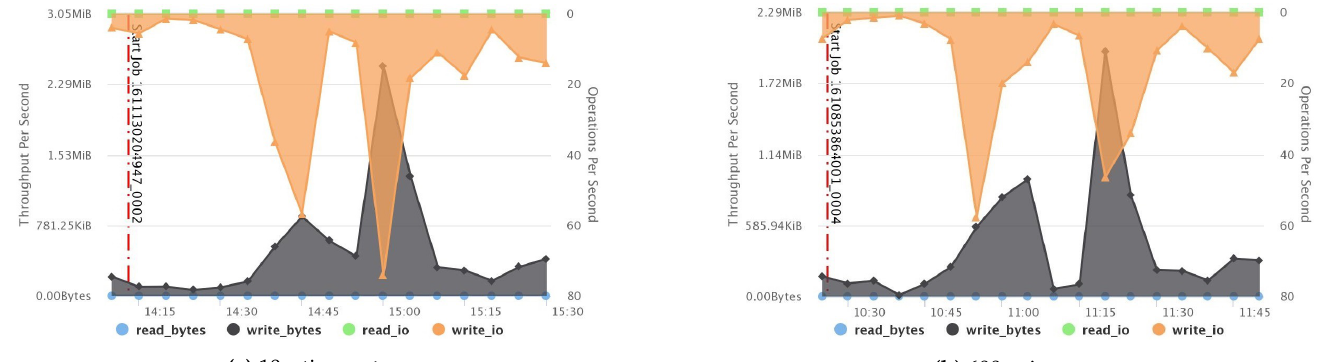
Figure 12. Comparison between disk usage when using small and default timeouts.